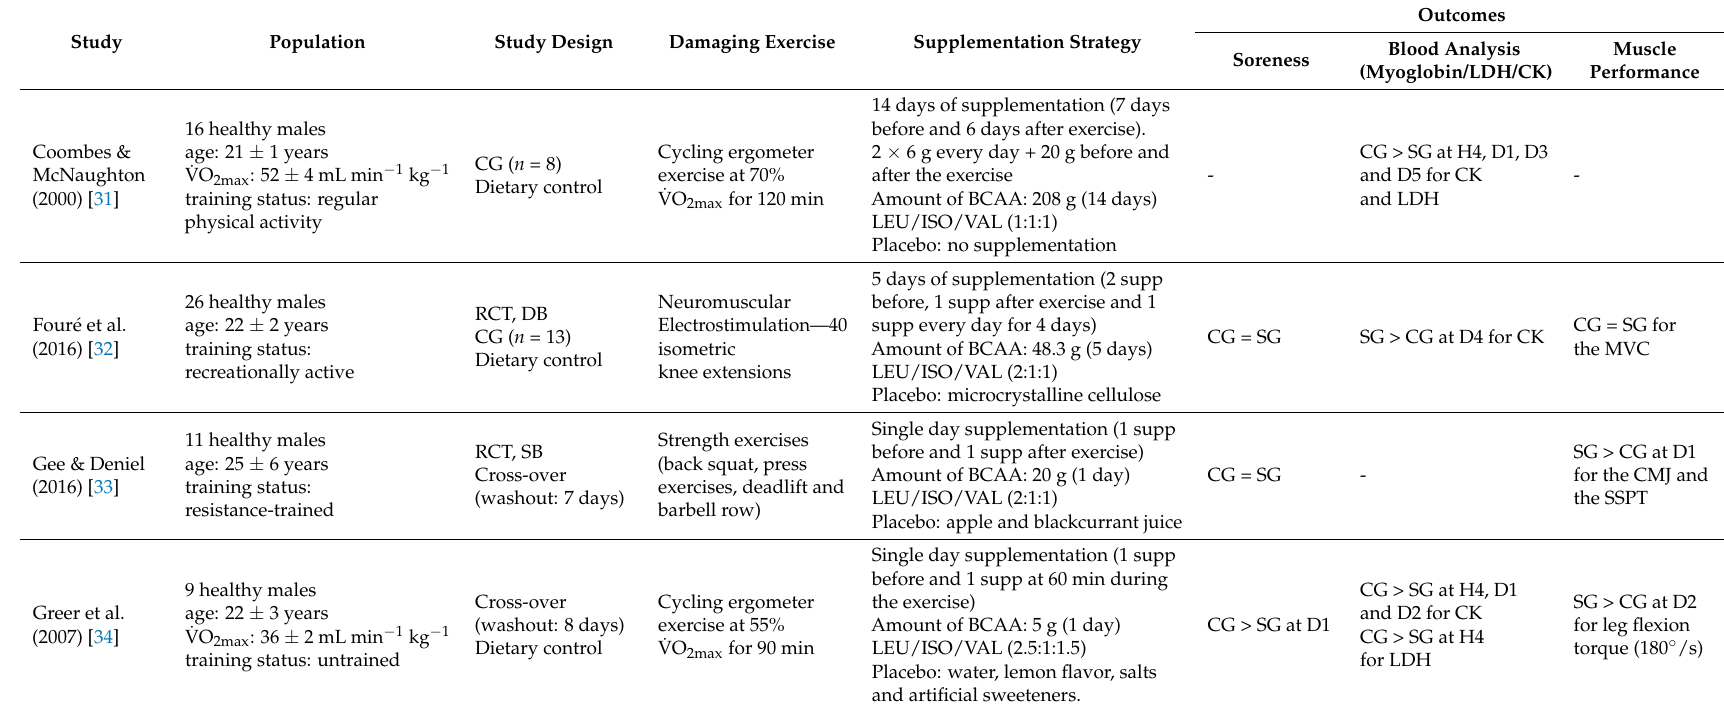
Table 2. Studies included in the systematic